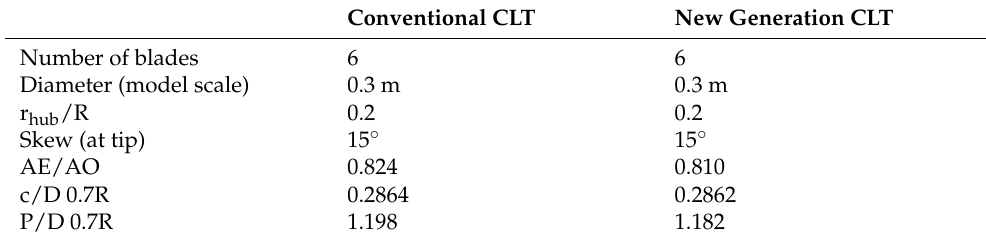
Table 1. Main geometrical characteristics of the test case propellers. Conventional CLT New Generation